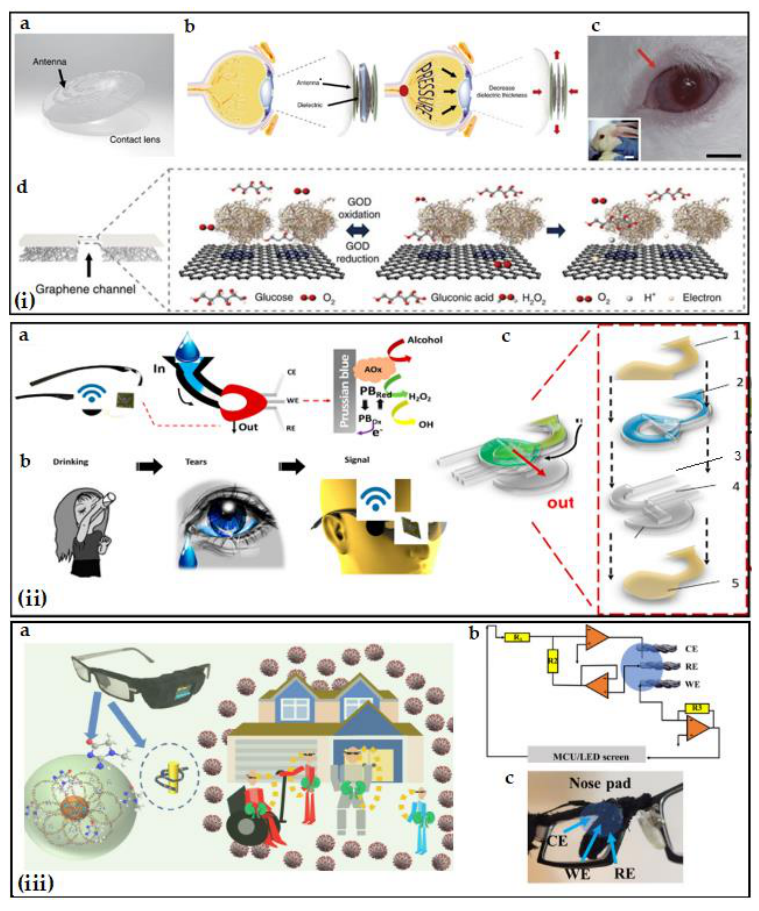
Figure 2. Real-time tear detection via wearable electrochemical sensors. ( i ) Smart contact lens for glucose and IOP detection. ( a ) Schematic illustration of the smart contact lens with IOP and glucose sensing. ( b ) Schematic illustration of working mechanism for IOP detection. ( c ) Photograph of the sensor integrated onto the eye of a live rabbit. Black and white scale bars, 1 cm and 5 cm, respectively. ( d ) Schematic illustration of working principle of glucose detection (Reprinted from Ref. [34]). ( ii ) Lab-on-eyeglasses for alcohol detection. ( a ) Schematic illustration of the lab-on-eyeglasses and working mechanism for alcohol detection via enzymatic measurement. ( b ) Schematic illustration of the procedure. ( c ) Structure of the fluidic device: (1) top polycarbonate membrane, (2) double-adhesive paper, (3) paper outlet, (4) electrochemical sensor and (5) bottom polycarbonate membrane (Reprinted with permission from Ref. [14]. Copyright 2019 Elsevier; Reprinted with permission from Ref. [91]. Copyright 2022 American Chemical Society). ( iii ) Lab-on-eyeglasses for creatinine detection. ( iii ) ( a ) Representative image of lab-on-eyeglasses with disposable hybrid textile electrodes selective for tear creatinine to monitor kidney diseases during daily life. ( b ) Circuit design of a textile-based integrated electrochemical sensor microcontroller with real-time monitoring. ( c ) Photograph of the three electrodes integrated into the nasal pad of the lab-on-eyeglass (Reprinted with permission from Ref. [63]. Copyright 2021 American Chemical Society).